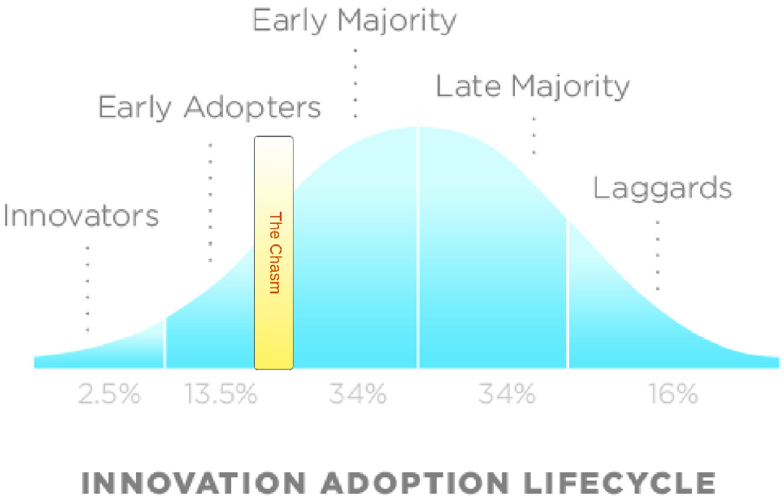
Figure 1. A tech innovation curve according to Roger’s diffusion of innovation social science theory [33] (own elaboration with Lusidchart -Lusid Software Inc., Salt Lake City, UT, USA, https://lucid.app/lucidchart-Original (accessed on 2 February 2023) picture used under the Creative Commons Attribution-Share Alike 3.0 Unported license from